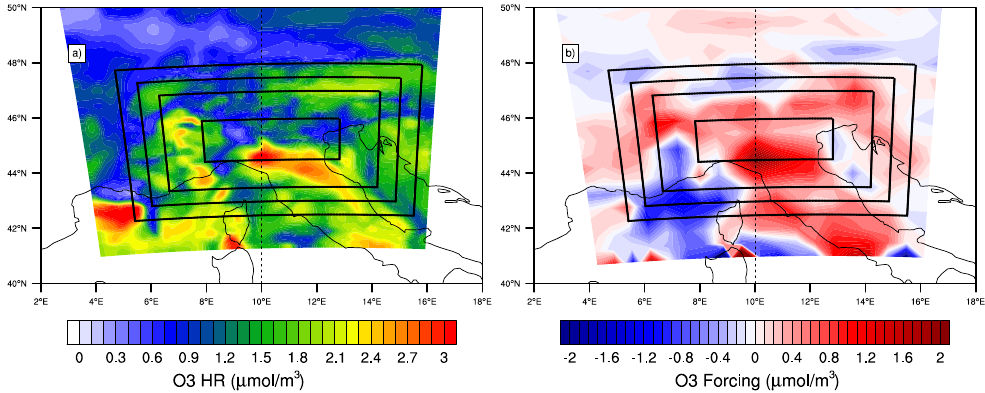
− C C HRr LR for 2005-06-17 06:00 UTC (right